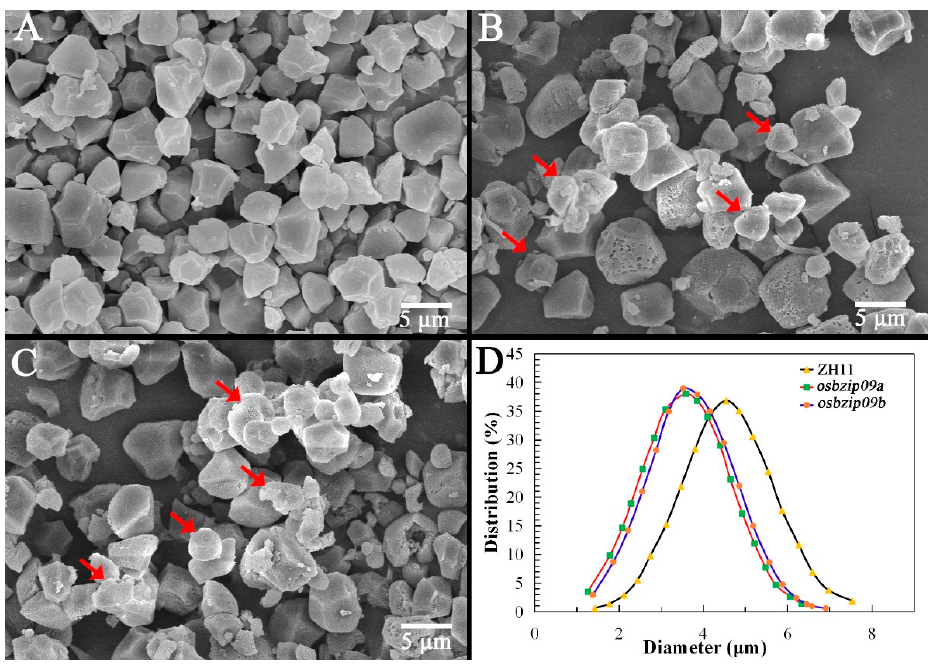
Figure 2. SEM images of starch and the corresponding starch granule size distribution. ( A – C ) rep- resent SEM micrographs of purified starches from ZH11, osbzip09a , and osbzip09b , respectively; ( D ) shows the size distributions of the purified starches ( n = 500). ( D ) shows the size distributions of the purified starches ( n =